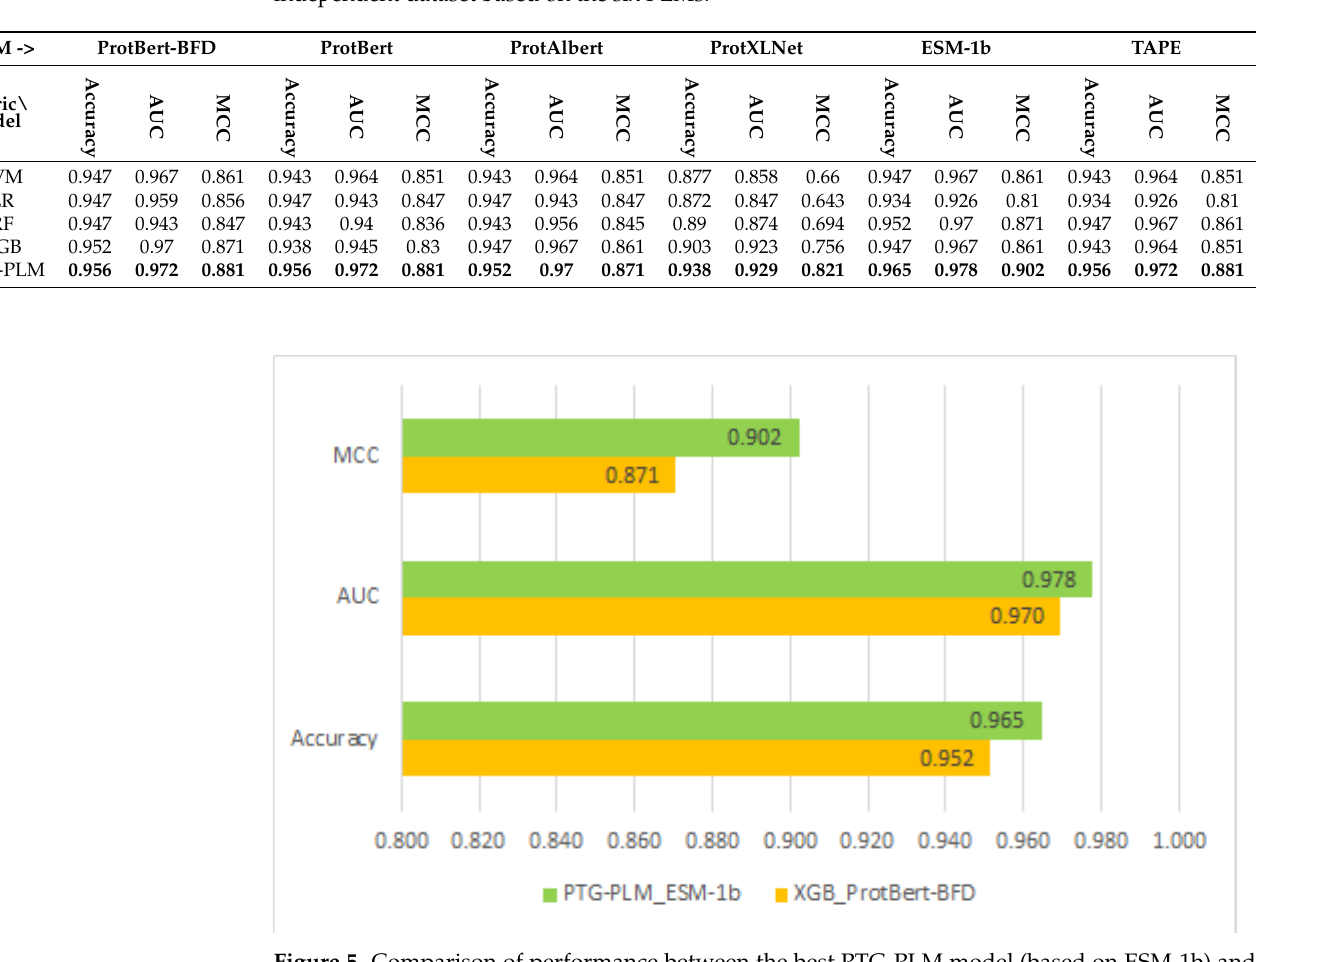
Table 7. Performance of PTG-PLM compared with four supervised learning methods on the Ngly independent dataset based on the six PLMs.